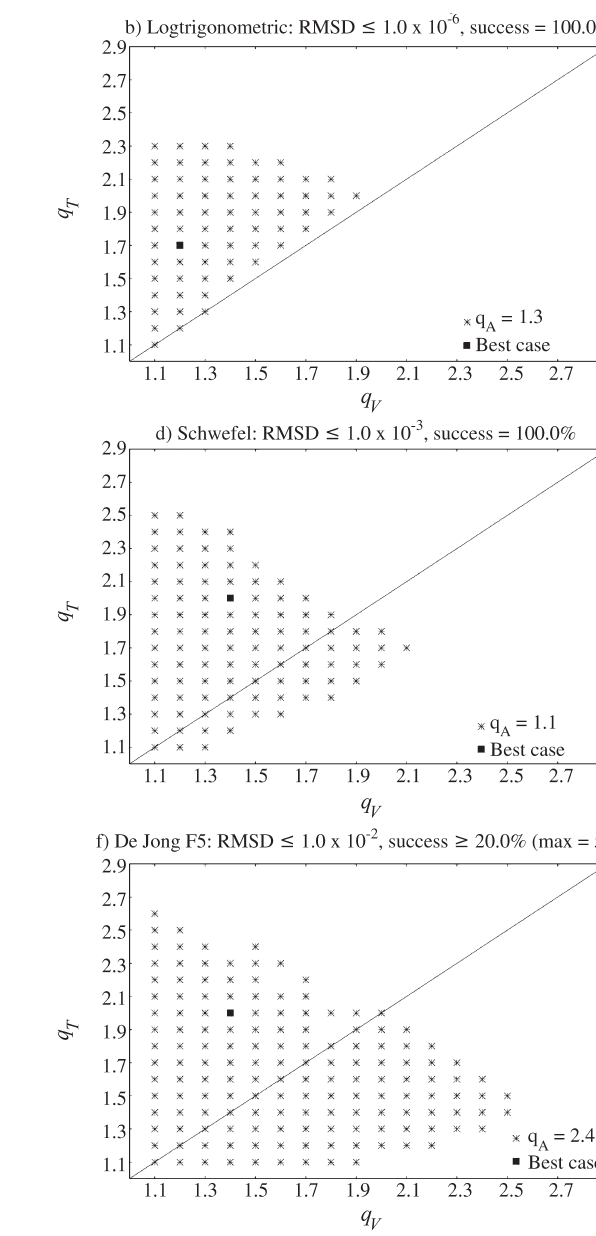
Figure 2 - SGSA parameters q V and q T for the best q A value with 100% success in 50 runs. For the De Jong F5 function a success index of more than 20% was